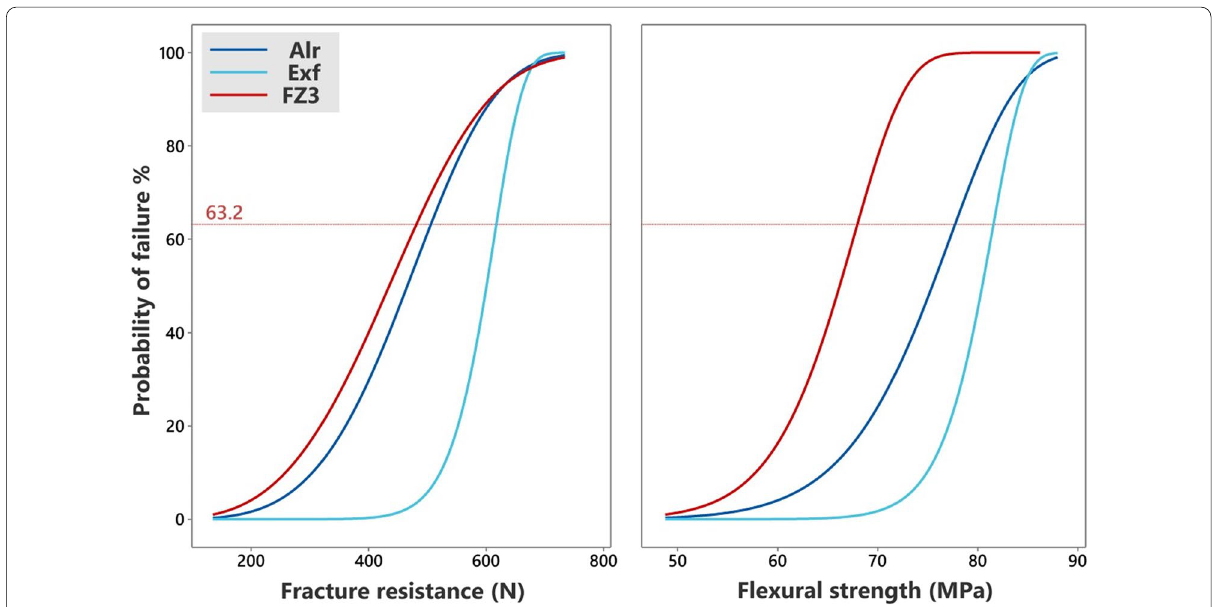
Fig. 2 The Weibull probability plot of the Fracture resistance (N) and flexural strength (MPa) of tested groups. The horizontal line at 63.2% probability of failure was added for comparison between the groups. Air: Alert composite, Exf: Ever X Flow-, and FZ3: